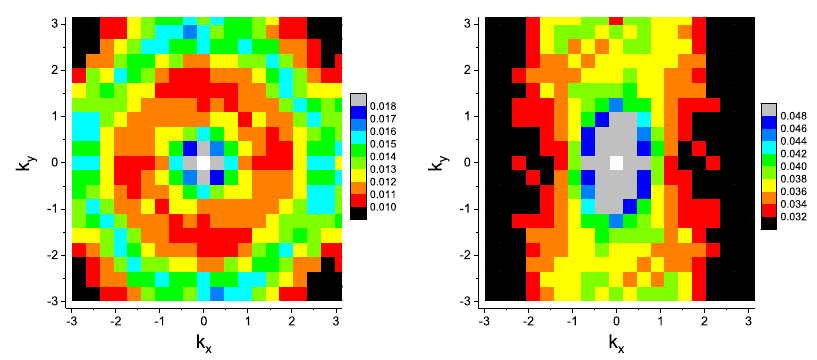
Figure 8: The LDOS Fourier transform ρ ( k ) profile averaged over 1000 disorder configurations for (a) a symmetric model, and (b) a nematic model. The rest of the settings are identical to those in Fig.